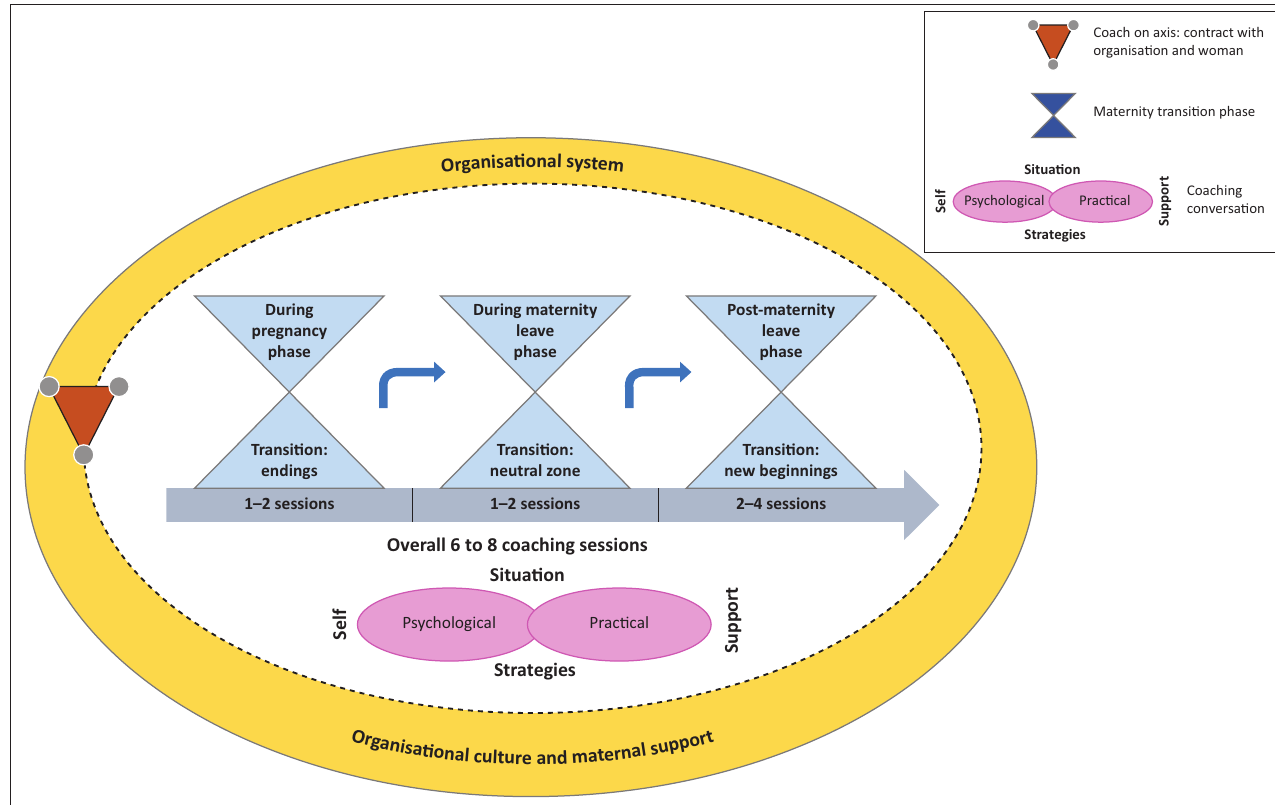
FIGURE 1: Maternity Transition Coaching